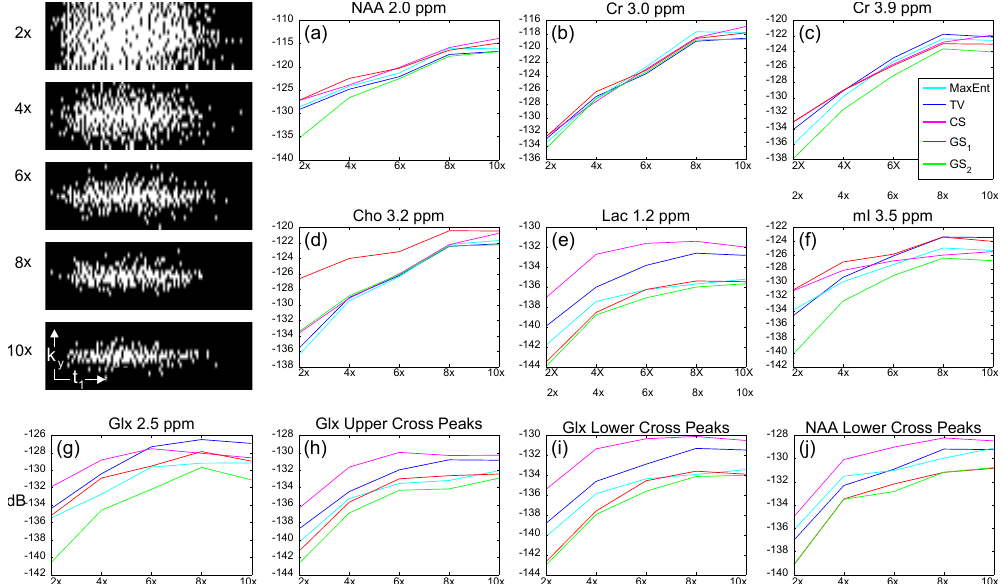
Figure 3. (Top Left) NUS masks used to under-sample the k scans 2 × , 4 × , 6 × , 8 × , and 10 × ( a – j ) Mean metabolite peak RMSEs of under-sampled 4D EP-COSI brain phantom scans with respect to the fully sampled data versus NUS rate for TV, MaxEnt, CS, GS , and GS 1 2